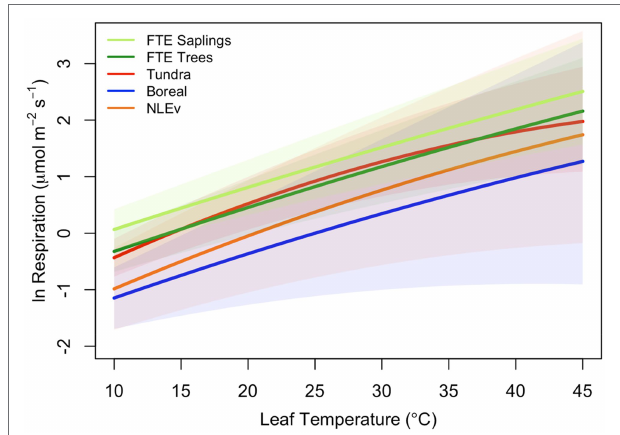
FIGURE 3 | Comparison of polynomial models fits from Heskel et al. (2016) with the average fits measured on two size classes of Picea glauca at the FTE in Northern Alaska. Response plotted are for the tundra biome (red line), boreal biome (blue line), needle-leaved evergreen plant functional type (orange line), FTE trees (>10 cm; dark green line), and FTE saplings (5–10 cm DBH; light green line).